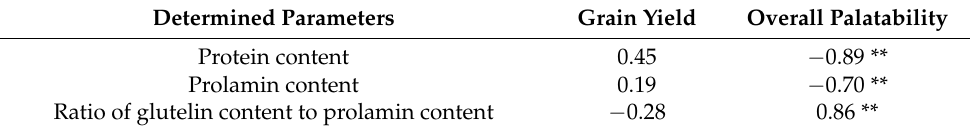
Table 8. Cont . Determined Parameters Grain